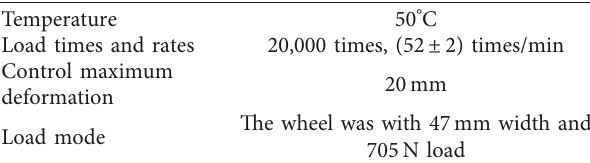
Figure 8: Installed specimens. Table 3: Control conditions of the Hamburg wheel tracking